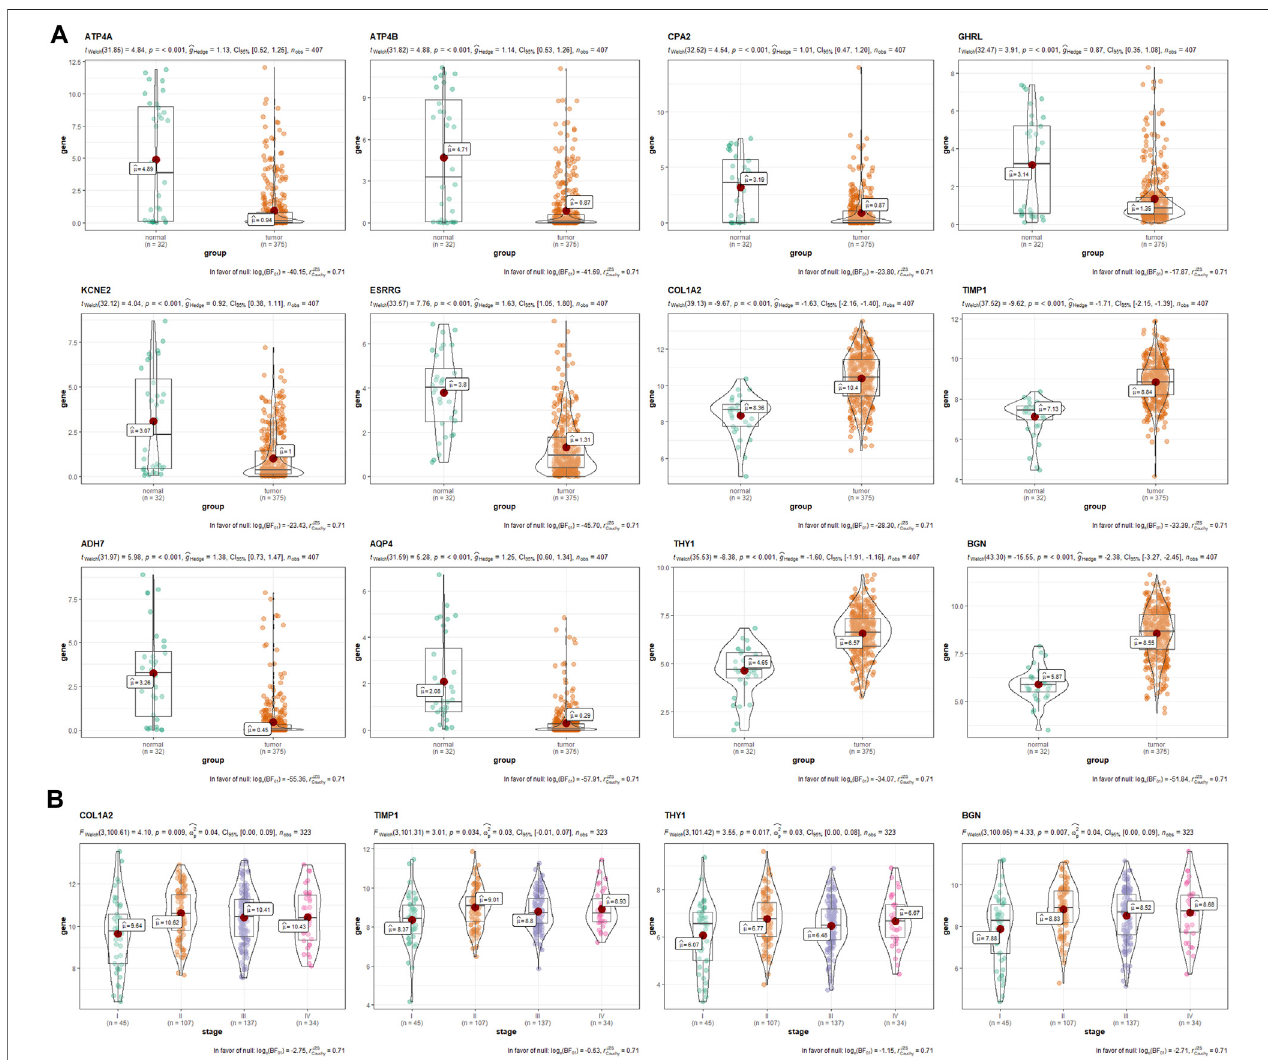
FIGURE 3 | The veri fi cation and exploration of signi fi cant DEGs in TCGA database. (A) comparison of the expression levels of ATP4A, ATP4B, CPA2, GHRL, KCNE2, ESRRG, COL1A2, TIMP1, ADH7, AQP4, THY1, and BGN between GC and paracancer tissues from TCGA database. (B) the association between the expression levels of COL1A2, TIMP1, THY1, and BGN with tumor stage. DEGs, differentially expressed genes; TCGA, The Cancer Genome Atlas; GC, gastric cancer.